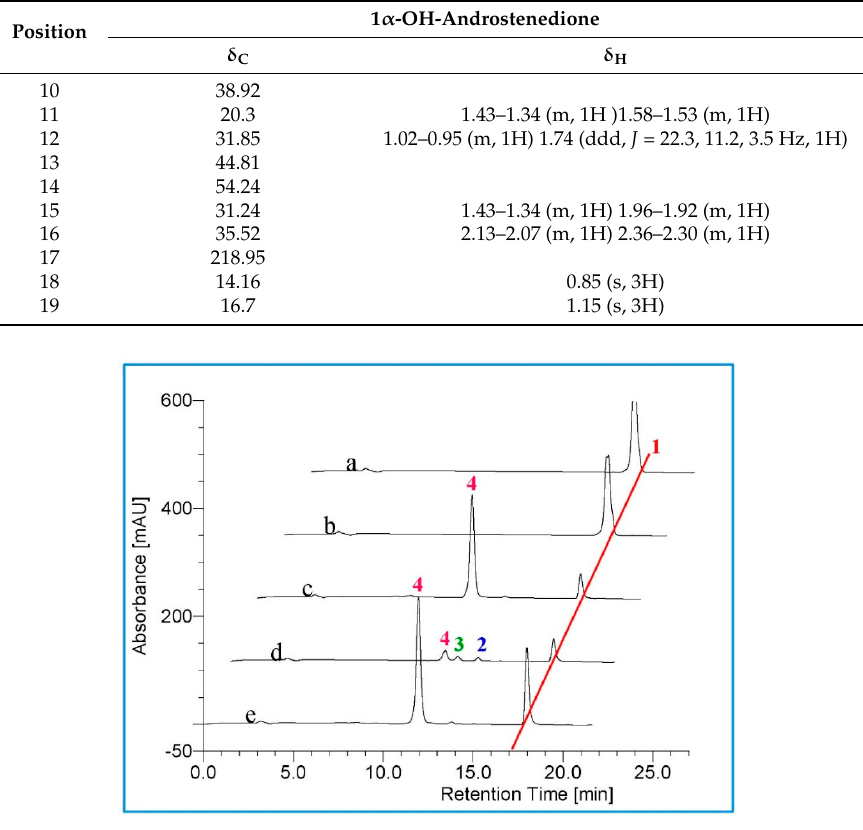
Figure 10. ( a ) HPLC chromatogram of androstenedione; ( b – e ) androstenedione incubations with empty vector, M01A82W, M01A82WS72I and M11A82W, respectively. Peak 1 shows the androstenedione standard; peaks 2, 3 and 4 are three monohydroxylated metabolites of androstenedione.